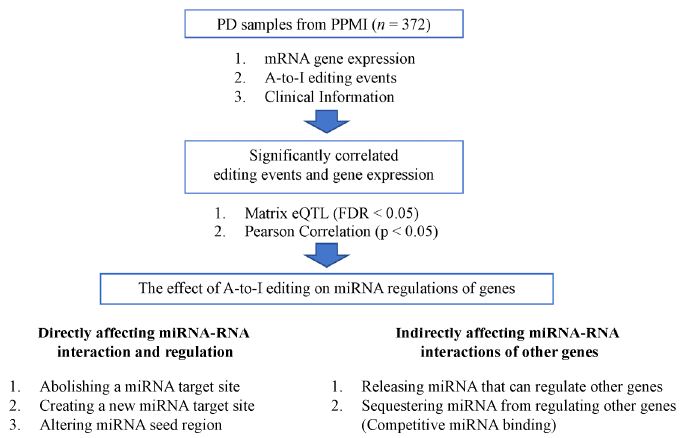
Figure 1. The flowchart of this study.